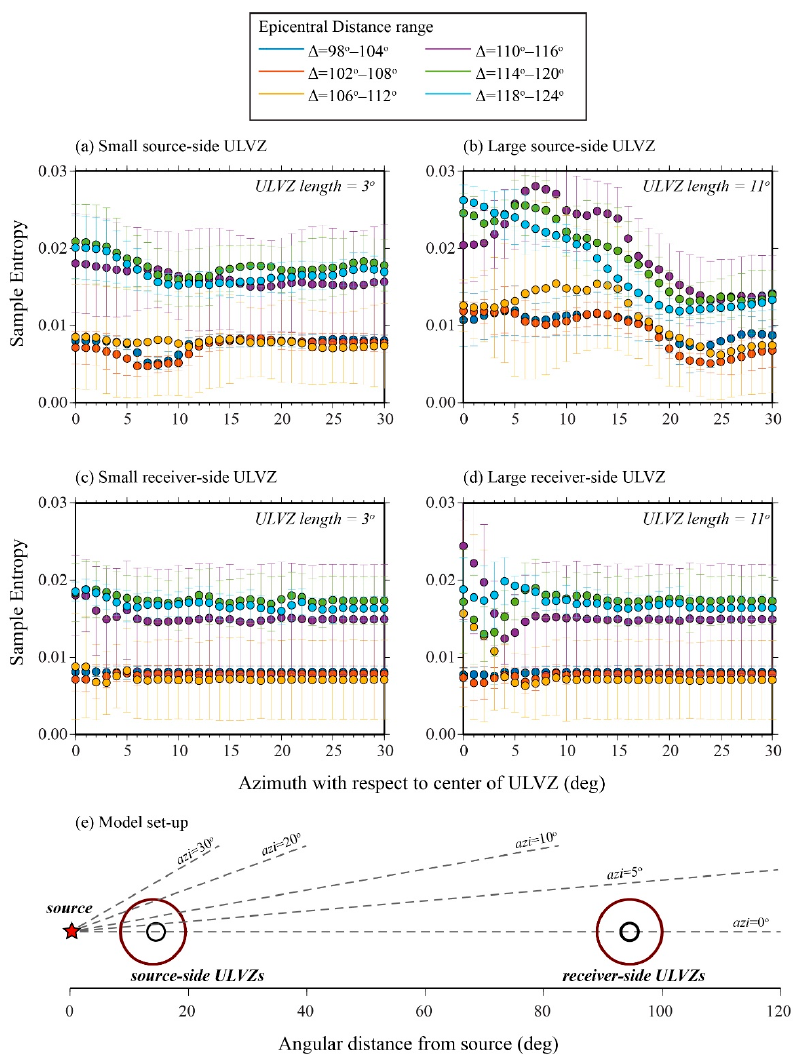
Figure 10. Sample entropy of 3-D ULVZ models. In each panel the sample entropy is shown for synthetic seismograms grouped into epicentral distance bins of 98°–104° (blue), 102°–108° (red), 106°–112° (orange), 110°–116° (purple), 114°–120° (green), and 118°–124° (cyan). The sample entropy is averaged in 1° azimuth bins and 1- σ standard deviation bars are drawn with the same colors. Each panel shows results for a different ULVZ model. ULVZ model parameters are: ( a ) h = 20 km, δ V S = − 45%, δ V P = − 15%, l = 3°, Δ edge = 13°, ( b ) h = 25 km, δ V S = − 20%, δ V P = − 15%, l = 11°, Δ edge = 8.5°, ( c ) h = 20 km, δ V S = − 45%, δ V P = − 15%, l = 3°, Δ edge = 93°, and ( d ) h = 25 km, δ V S = − 20%, δ V P = − 15%, l = 11°, Δ edge = 89°. ( e ) The model setup is shown in map view along the CMB. ULVZs are indicated by the open circles with lengths l = 3° drawn in black and lengths l = 11° drawn in red with respect to the location of the source (red star). Dashed lines are drawn to indicate azimuths of 0°, 5°, 10°, 20°, and 30°.